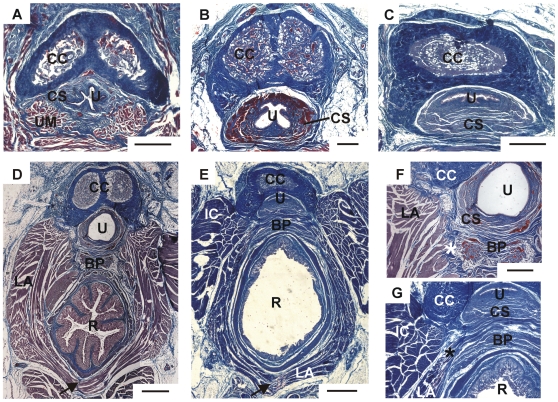
Comparison of penile structures in naked, Damaraland, and silvery mole-rats.(A–C) Photomicrographs depicting the structure of the corpora cavernosa and corpus spongiosum in the naked mole-rat, Damaraland mole-rat, and silvery mole-rat, respectively. The urethral muscle is seen at this level in the naked mole-rat (A); this muscle does not extend as far distally in the other two species. (D–E) The bulb of the penis is shown in Damaraland (D) and silvery mole-rats (E), in relation to neighboring structures. (F) Higher power view of the section in (D), showing LA fibers attaching to the bulb of the penis (asterisk) and to the corpus cavernosum. (G) Higher power view of the section in (E), showing LA fibers attaching solely to the bulb of penis (asterisk). Abbreviations: BP, bulb of penis; CC, corpora cavernosa; CS, corpus spongiosum; IC, ischiocavernosus; LA, levator ani; R, rectum; U, urethra. Scale bars in A–C, F, G = 500 µm; D, E = 1 mm.